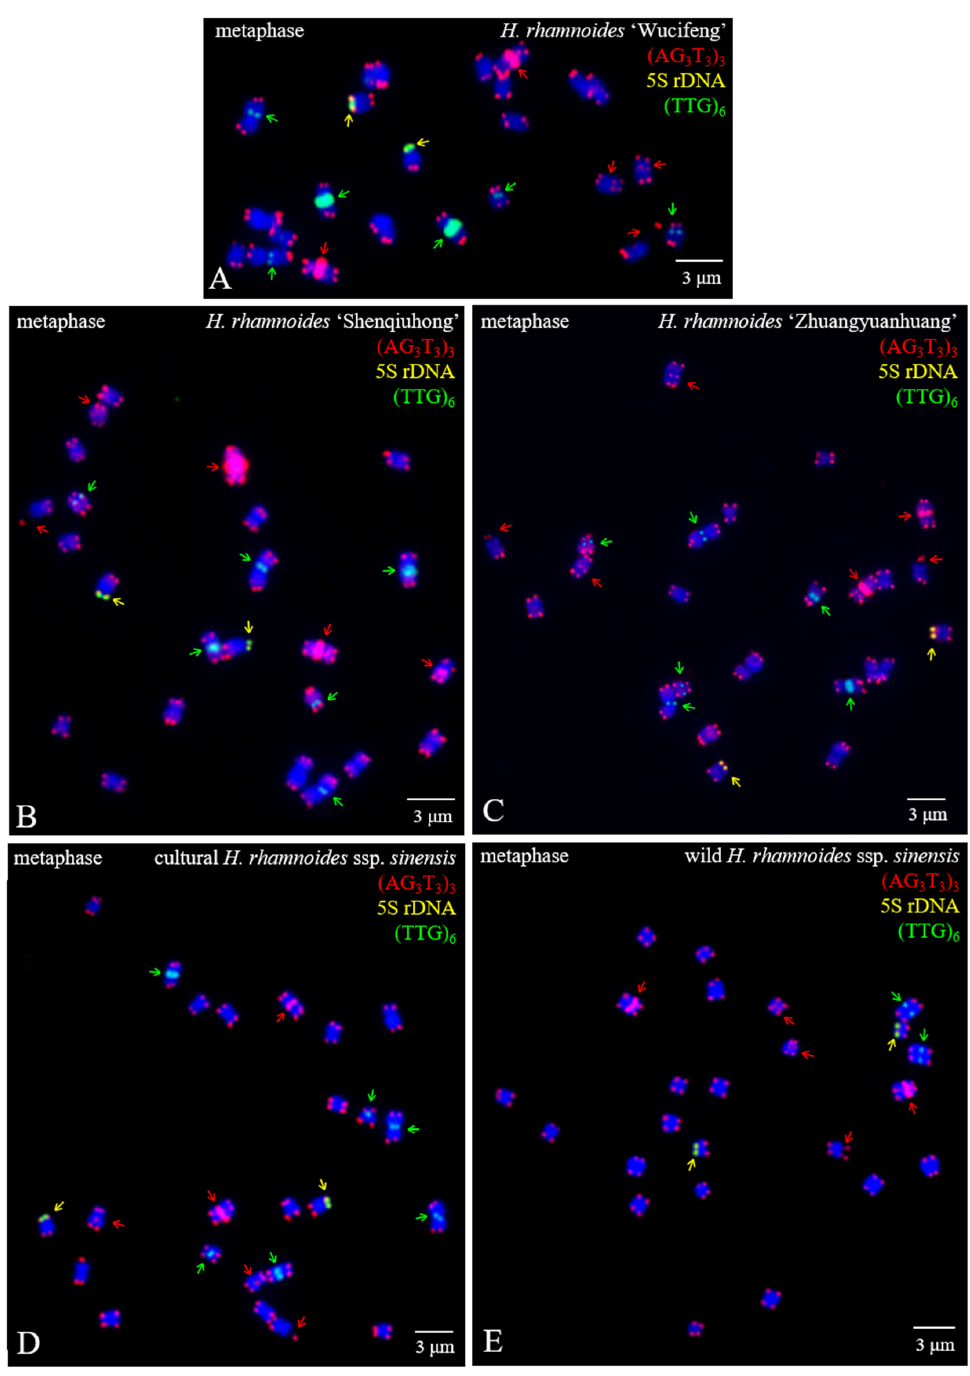
Figure 1. Mitotic metaphase chromosomes of Hippophaë rhamnoides detected using (AG 3 T 3 ) 3 (red), 5S rDNA (yellow), and (TTG) 6 (green). ( A ) Hippophaë rhamnoides ‘Wucifeng’, ( B ) H. rhamnoides ‘Shenqiuhong’, ( C ) H. rhamnoides ‘Zhuangyuanhuang’, ( D ) cultural H. rhamnoides ssp. sinensis , and ( E ) wild H. rhamnoides ssp. sinensis . Red arrows show (AG 3 T 3 ) 3 located at the interstitial region of a chromosome or at the telomere region far away from the chromosome end, whereas yellow arrows show 5S rDNA and green show (TTG) 6 . (AG 3 T 3 ) 3 located at the chromosome end is not indicated with an arrow. The blue chromosomes were counterstained by DAPI. Scale bar = 3 µ